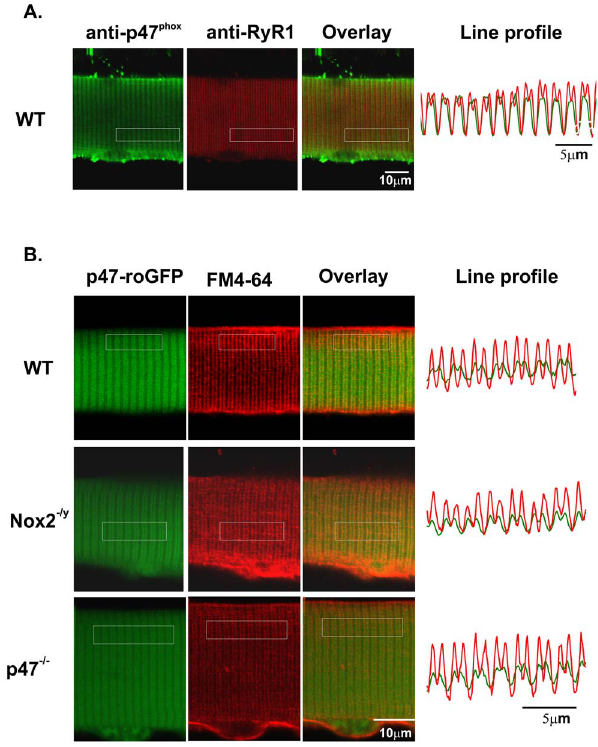
Figure 6. Electrical stimulation induces oxidation of DCF in myofibers from WT but not p47 2 / 2 or Nox2 2 /y mice. Tetanic electrical stimulation increased the normalized rate of DCF fluorescence (red bar) compared to pre-stimulated values (black bar). In addition, the rate of change of DCF fluorescence was significantly lower in FDB fibers from p47 phox 2 / 2 and Nox2 2 /y mice compared to WT FDB fibers. There was no difference between non-stimulated and stimulated condition for either p47 2 / 2 or Nox2 2 /y . Data are analyzed from n animals =6 per strain, 12 replicates per animal. ** p , 0.01 (Tukey statistical analysis for p